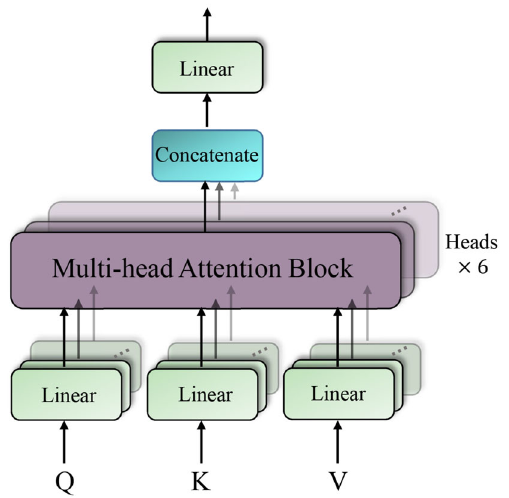
Fig. 6 Multi-head attention